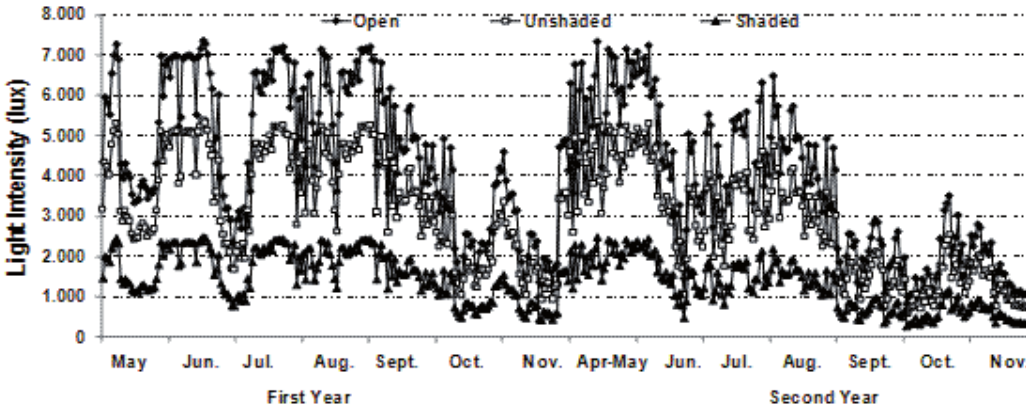
Fig. 2: The light intensity data of nursery conditions with respect to years